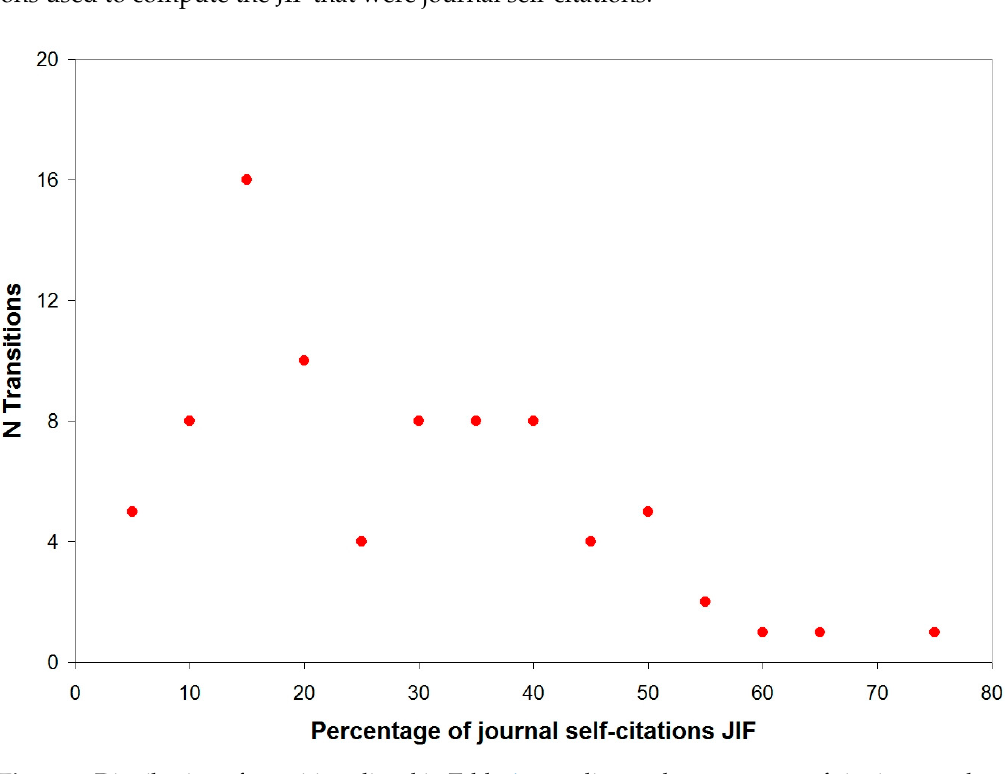
Figure 2. Distribution of transitions listed in Table 4 according to the percentage of citations used to compute the JIF that were journal self-citations.